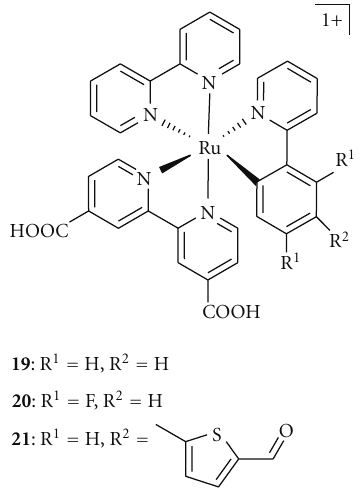
Figure 34: Molecular structures of 19 – 21 (taken from [58]).